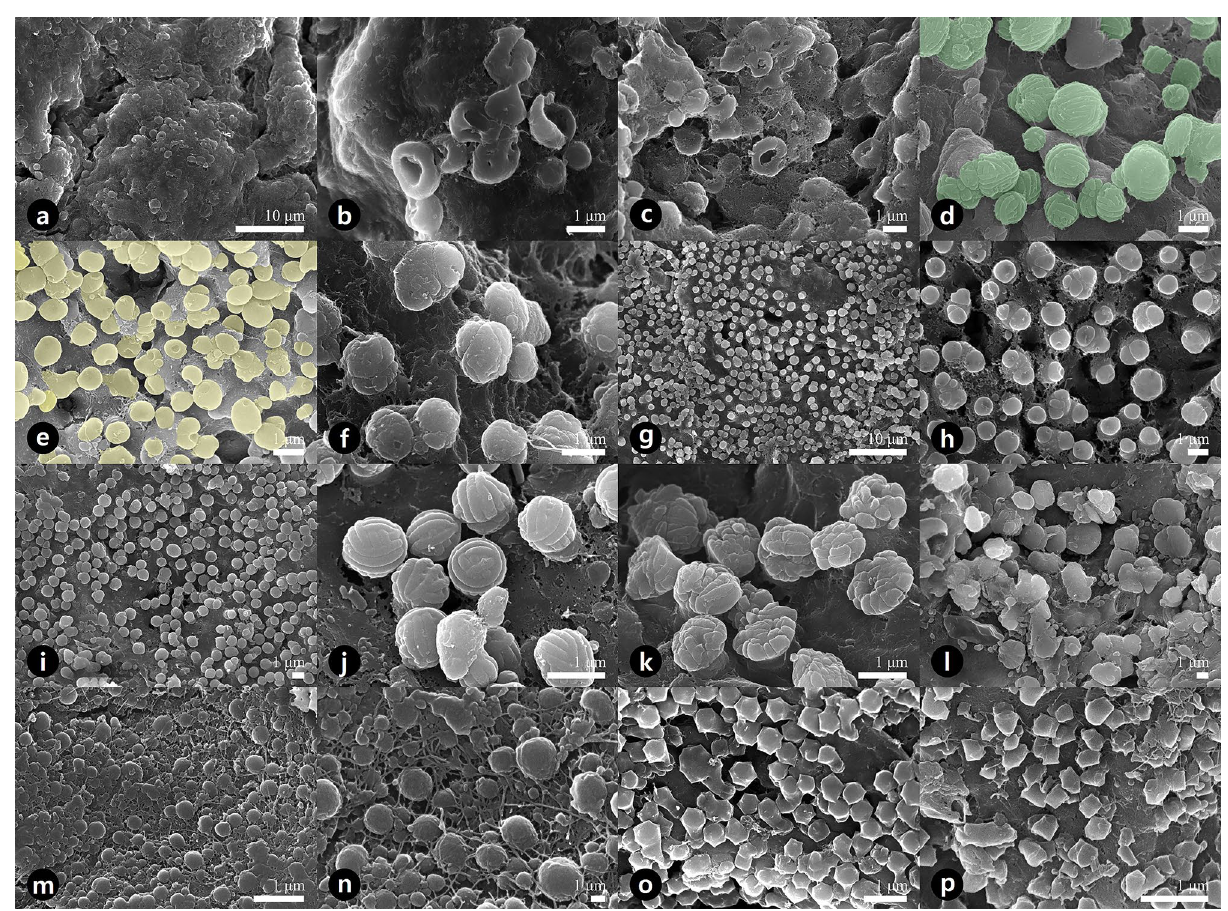
Figure 5. Scanning electron micrographs showing the orbicules on the inner locule walls. ( a , b ) Aristolochia contorta . ( c ) Aristolochia manshuriensis . ( d ) Asarum koreanum . ( e ) Asarum mandshuricum var. mandshuricum . ( f ) Asarum mandshuricum var. seoulense . ( g , h ) Asarum misandrum . ( i , j) Asarum patens . ( k ) Asarum sieboldii . l Asarum versicolor . ( m , n ) Houttuynia cordata . ( o ) Piper kadsura . ( p ) Saururus chinensis